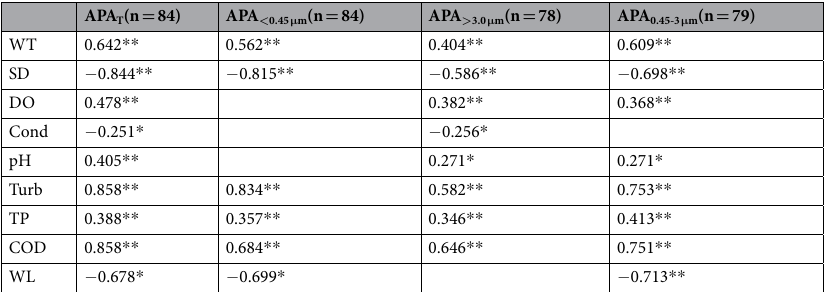
Table 1. Spearman correlations between APA and 10 environmental variables: water temperature (WT); transparency (SD); dissolved oxygen (DO); conductivity (Cond); pH, turbidity (Turb); total phosphorus